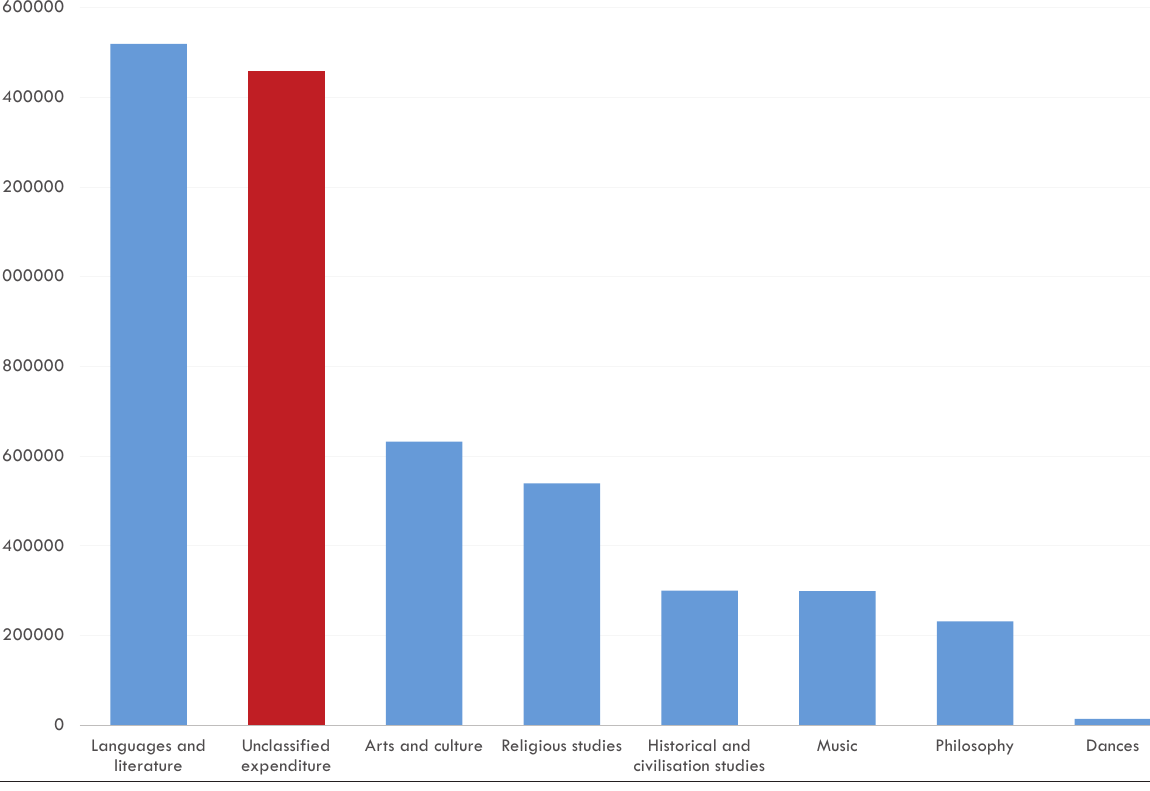
Figure 4: Total GERD by humanities research field over 10-year period